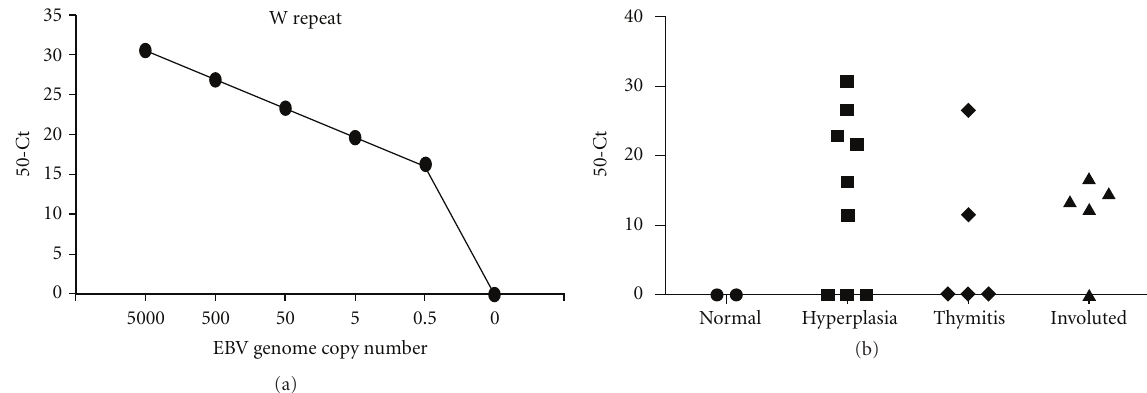
Figure 3: Real-time PCR for EBV genome detection ( Bam HI-W repeats). (a) Dilution series of DNA (ranging from 0.5 to 10 5 copies of EBV genome per reaction), extracted from the JY lymphoblastoid cell lines, were analysed as described in Section 2. Real-time PCR resulted in high and constant amplification e ffi ciency for > 0.5 copies of EBV genome per reaction. (b) Genomic EBV W repeats were detectable in 6/9 hyperplastic thymuses, 2/5 thymitis, and 4/5 involuted thymuses, but not in two nonpathological control thymuses. Real-time PCR was performed for 50 cycles, and results are expressed as